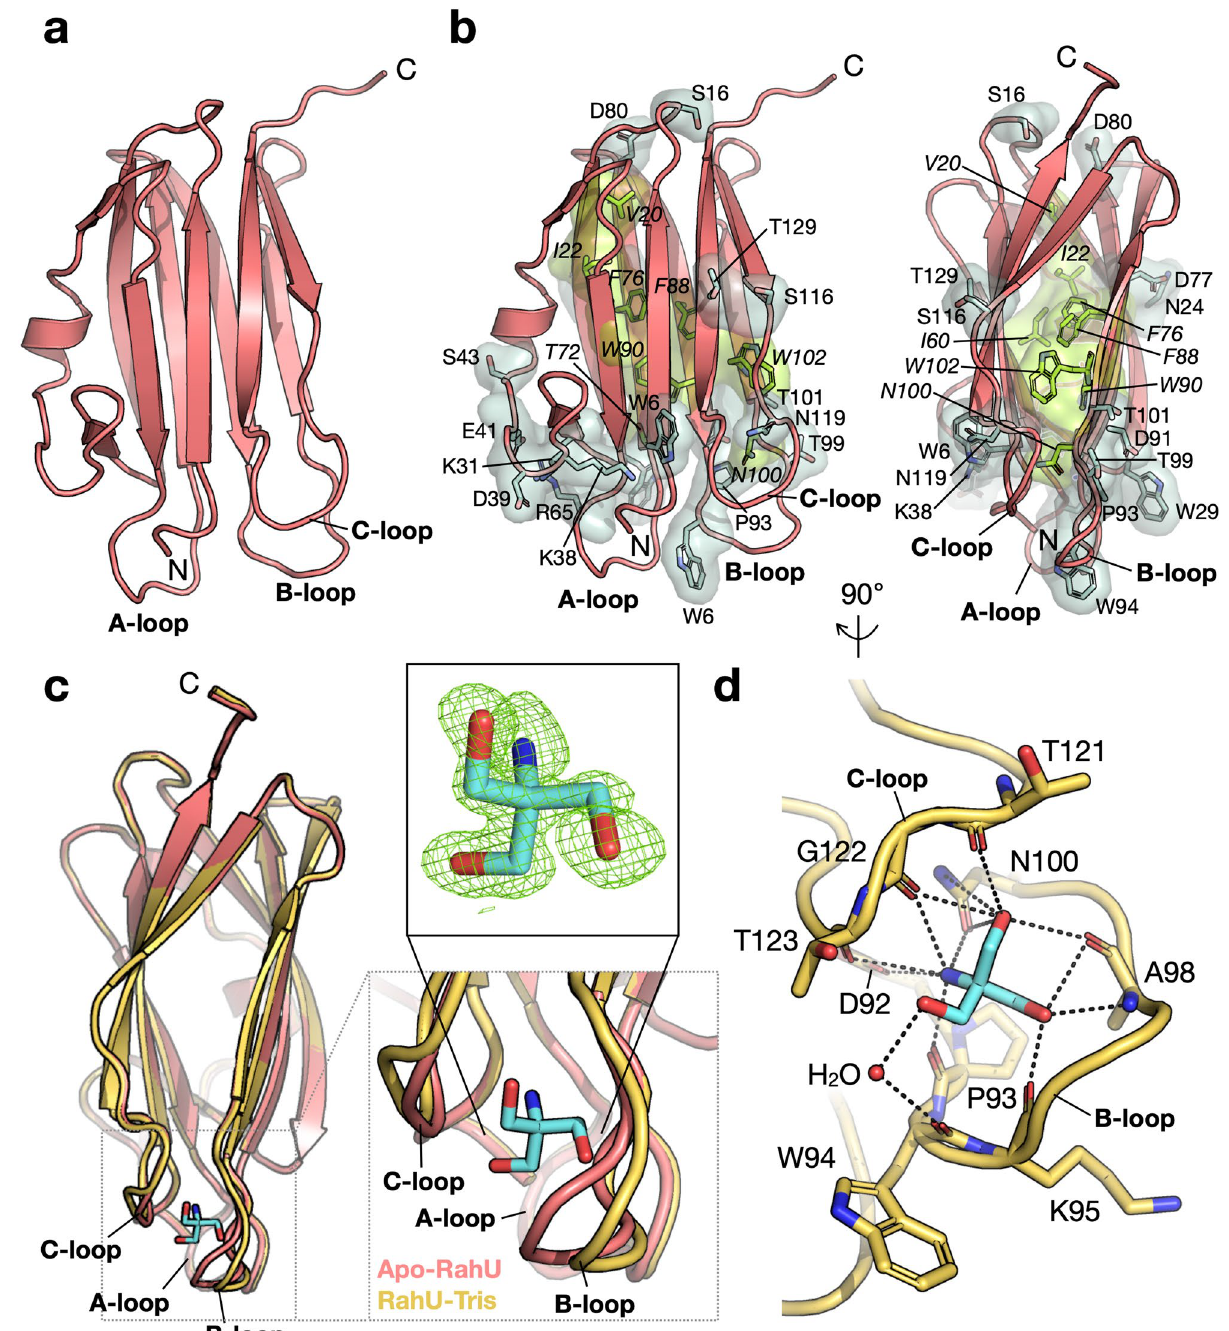
Figure 2. Structural analysis of RahU protein. ( a ) Overall crystal structure of apo-RahU. A-loop, B-loop and C-loop as well as N- and C-termini are indicated. ( b ) Conserved amino acid residues in RahU and fungal aegerolysins OlyA and PlyA are highlighted in sticks. Light green: amino acid residues of the hydrophobic β-sandwich core; light blue: solvent-exposed amino acid residues. Two orientations, 90° relative to each other, are shown. ( c ) Overall crystal structure of RahU (cartoon, yellow) in complex with a Tris molecule (sticks, light blue), compared to apo-RahU (cartoon, red). Insets: Close-up view of conformational differences upon Tris binding, and 3σ contoured Fo-Fc electron density (mesh) before the model of the Tris molecule was added. The model of Tris as positioned in the final refinement cycle is shown in sticks. ( d ) Tris binding-site analysis. Amino acid residues that are involved directly or indirectly via water molecule (shown as a non-bonded sphere) in the Tris binding are highlighted and shown in sticks. Hydrogen bonds with a distance below 3.5 Å between the ligand and amino acid residues are depicted in black dashed